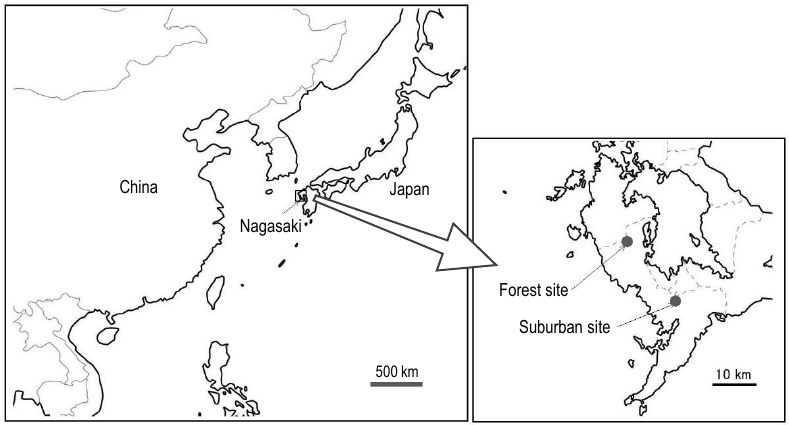
Figure 1. Location of the sampling sites. Suburban site: 32°47 ′ 07.9 ″ N, 129°51 ′ 52.6 ″ E; Forest site: 32°54 ′ 32.4 ″ N, 129°44 ′ 33.5 ″ E.